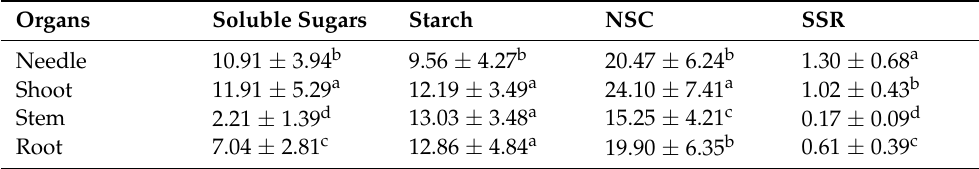
Table 3. Comparison of the concentrations of soluble sugars (% dm), starch (% dm), NSC (% dm), and the soluble sugar–starch ratio (SSR) in the needles, shoots, stems, and roots of L. principis-rupprechtii (mean ± SD). Different lowercase letters indicate significant differences at the 0.05 level. Organs Soluble Sugars Starch NSC